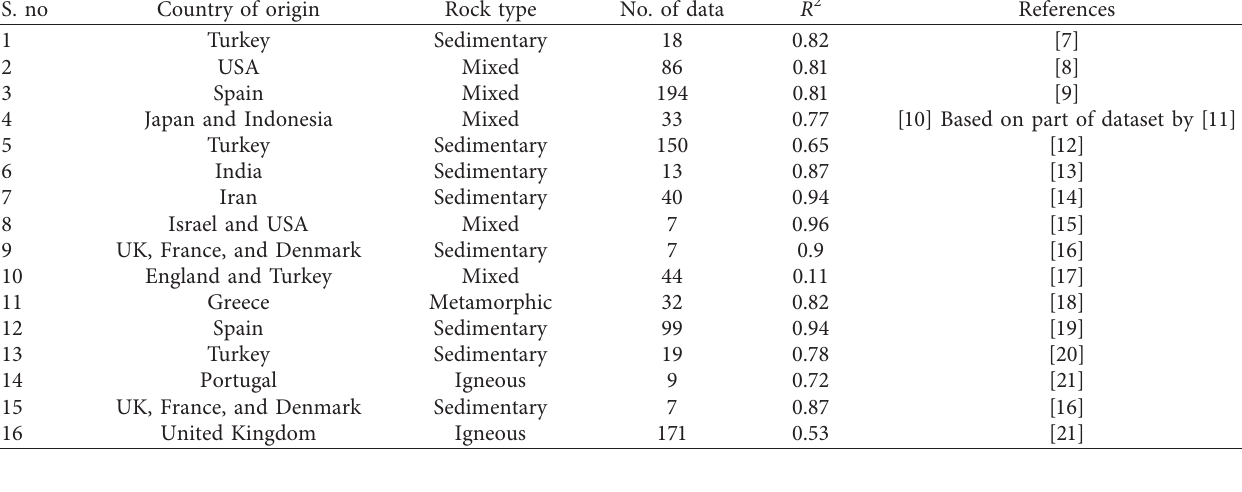
Table 1: Empirical equations proposed by the researchers for estimating